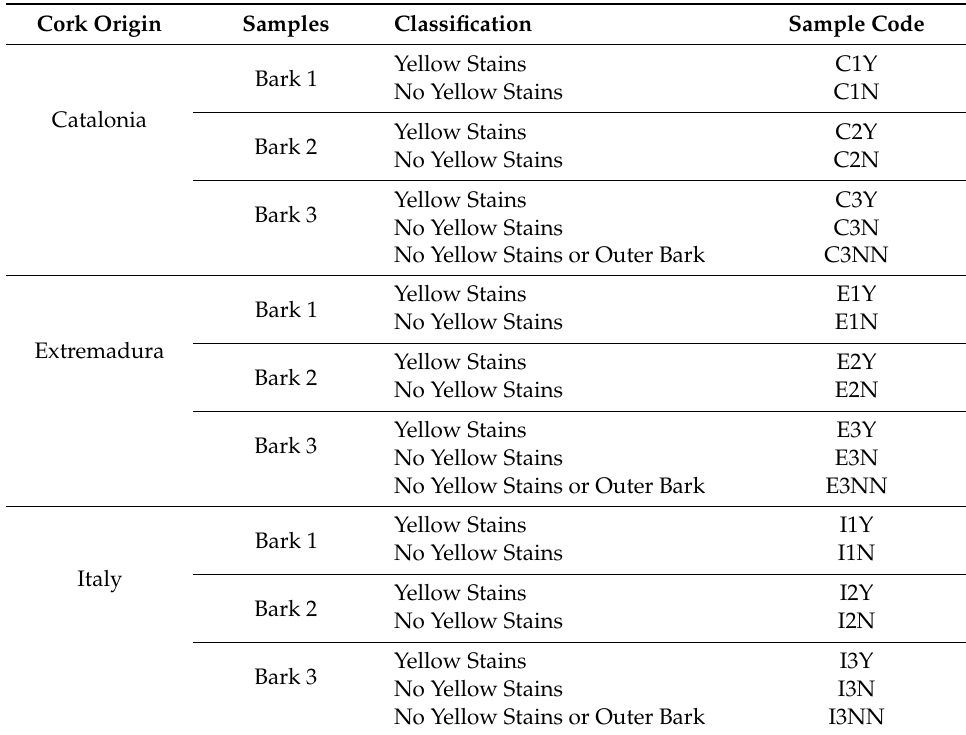
Table 2. Origin and classification of each sample depending on whether they had yellow stains or not. In cork samples labelled as C3NN, E3NN and I3NN, the outer cork part was